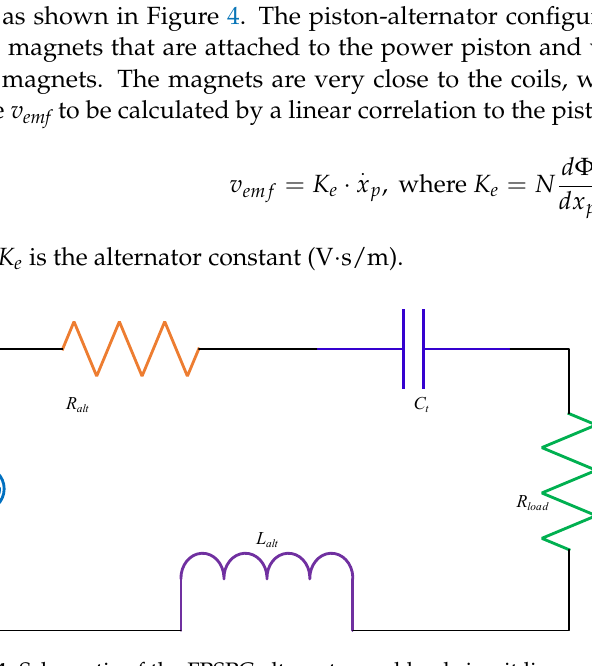
Figure 4. Schematic of the FPSPC alternator and load circuit linear model.